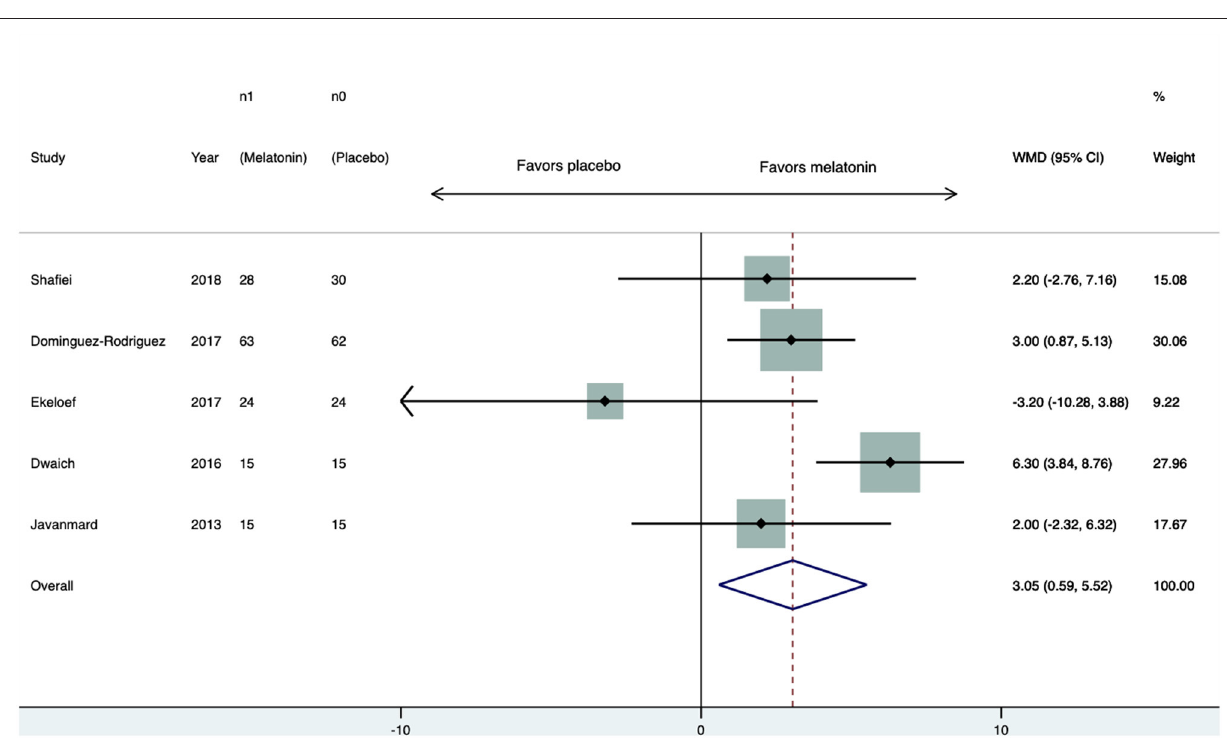
Frontiers in Cardiovascular Medicine |